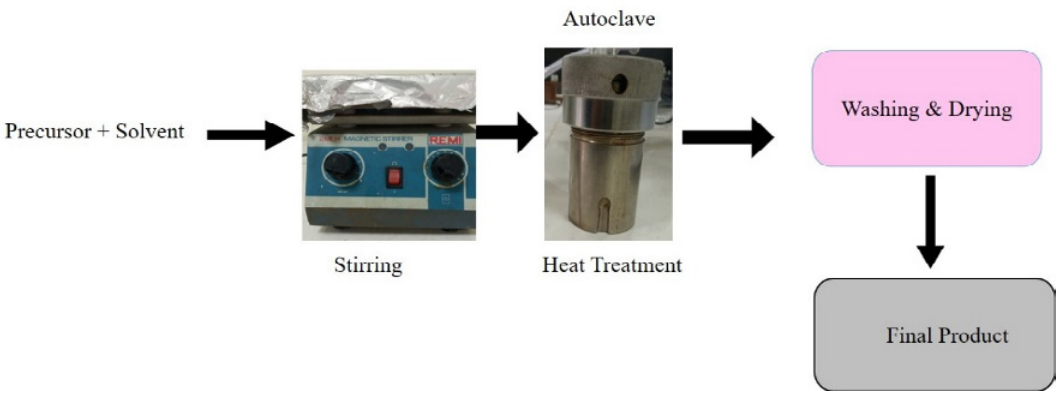
Fig. 6. Pictorial representation of the hydrothermal